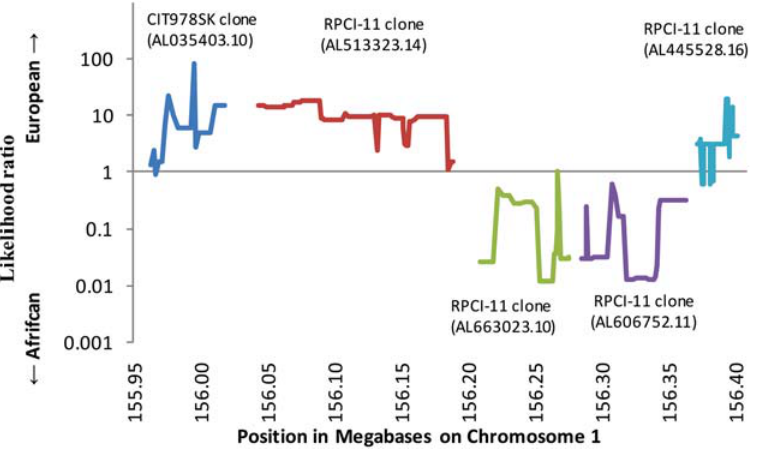
Figure 4. Ancestry analysis of BAC clones that are the source of the human genome reference sequence across the chromosome 1 locus. The human genome reference sequence across the admixture peak is pieced together from 5 BAC clones, which turn out to be a mosaic of European and African ancestry. To determine ancestry, we examined the haplotype of the human genome reference sequence for 284 SNPs for which data are available from the International Haplotype Map Project, and then output the ratio of the number of perfect matches to the reference sequence haplotype in 120 European American to the number of perfect matches in 120 West African chromosomes (conservatively adding 1 to the counts). Values above 10 indicate strong ( . 10:1) evidence for a European haplotype, and values below 0.1 indicate strong ( , 1:10) evidence for an African haplotype. RPCI-11, the individual who is the source of , 74% of the human genome reference sequence, has two clones of entirely African and two clones of entirely European ancestry at this locus, strongly indicating that the human genome reference sequence is primarily that of an African American. We included these BAC clones in our search for polymorphisms across the admixture peak that were consistent with being fixed in frequency between European and African populations.